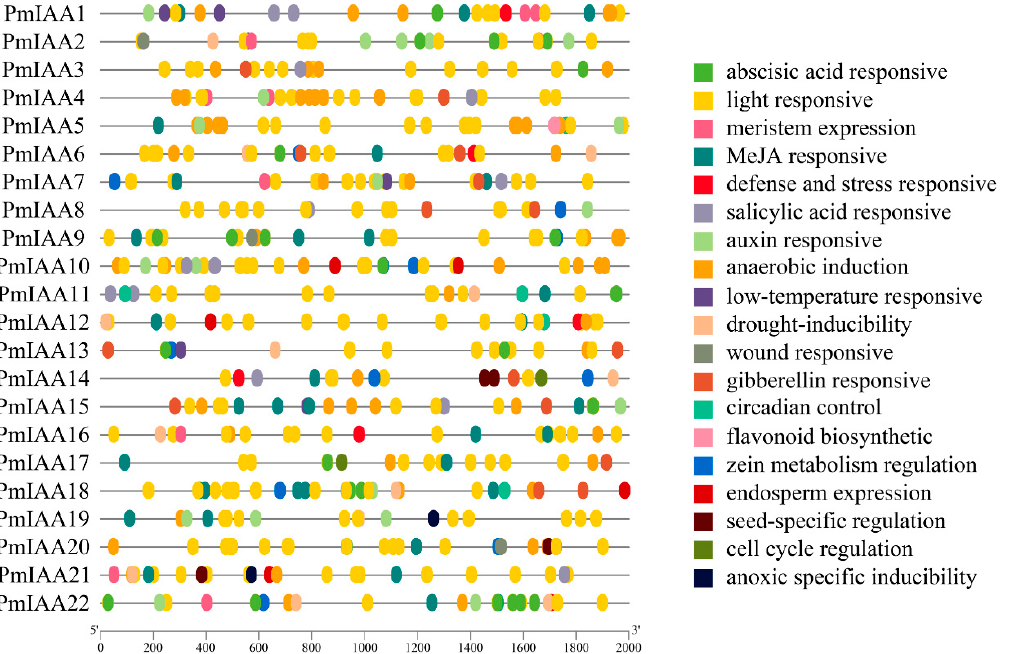
Figure 8. Cis-acting elements distribution in promoters of PmIAAs . The 2000 bp promoter sequences of PmIAA genes were used to analyze specific responsive cis-acting elements. Different colors indicated nineteen different cis-acting elements.